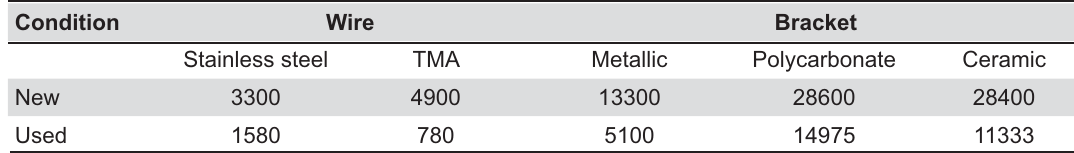
Table 1- Mean values for roughness in Å. Reading regarding 3-mm segment of each sample